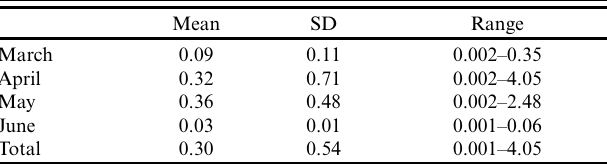
Table 2 . Monthly mean (± SD) chorus area (km2) for Greater Prairie-Chicken ( Tympanuchus cupido ) leks near Ainsworth, Brown County, Nebraska, USA, 2013–2014.